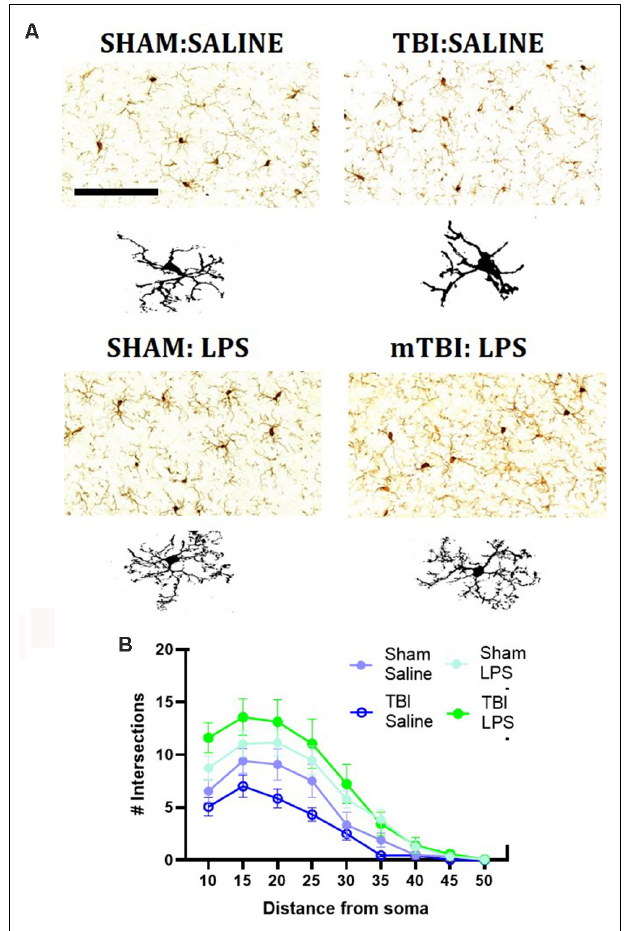
FIGURE 3 | Representative images of IBA1 immunostaining within the mPFC (A) , with representative microglial skeletons used for analysis (B) and analysis of morphology via Sholl plot (B) . Scale bar = 200 µ